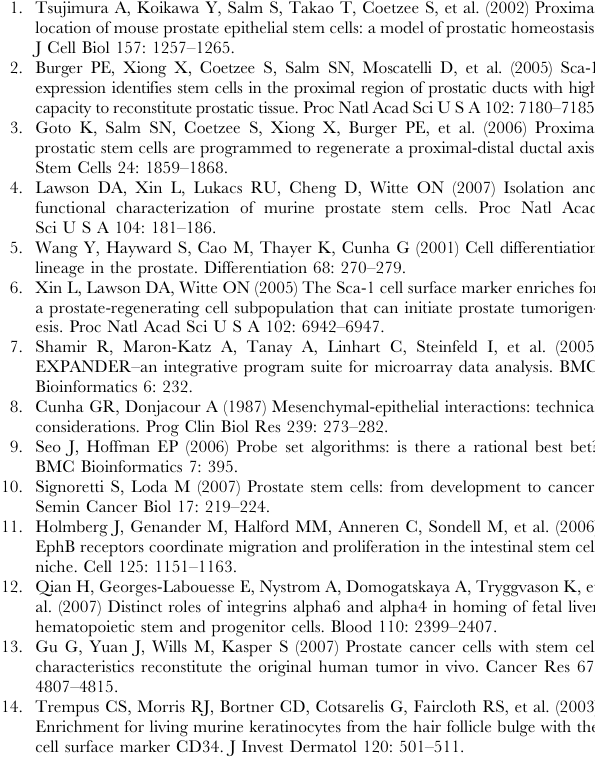
Table S13 Promoter sequence analysis of stem/progenitor clusters. A list of the genes associated with each of the enriched promoter motifs that were identified for the UGE-only, UGE + Sca-1Hi and Sca-1Hi-only clusters.